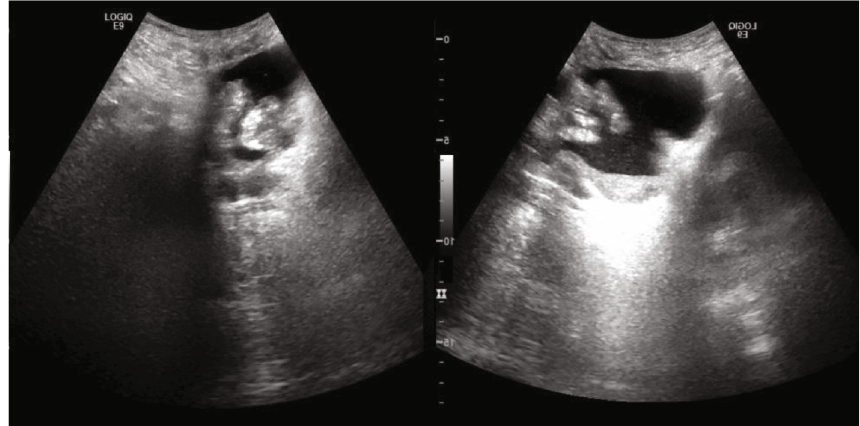
Figure 1: The fi rst bladder echography showing a thickening of the right lateral wall.